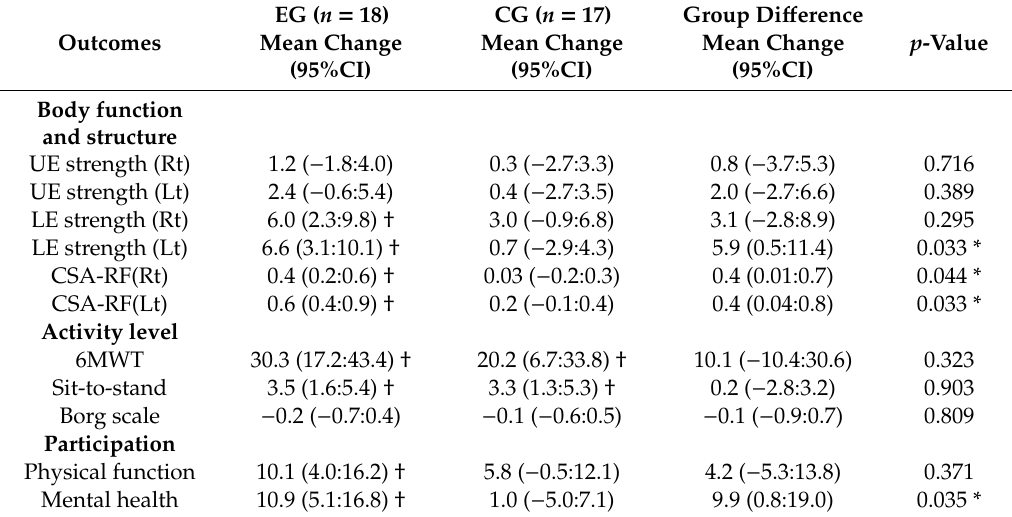
Table 3. Results of the paired t -tests and ANCOVA used to compare the changes after training within and between